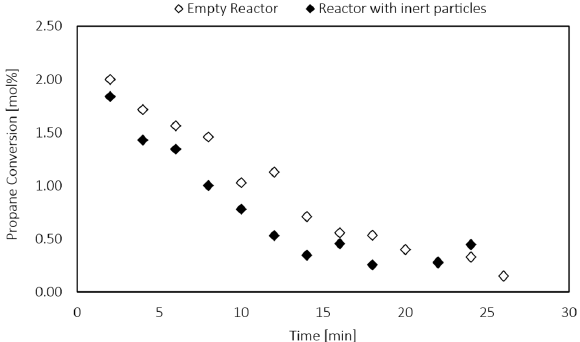
Figure A5. Blank test results for the empty reactor (empty dots) and the reactor filled with inert particles (full dots) at 500 ° C, atmospheric pressure, and feeding a mixture of 30vol% C 3 H 8 -70 vol% N 2 .